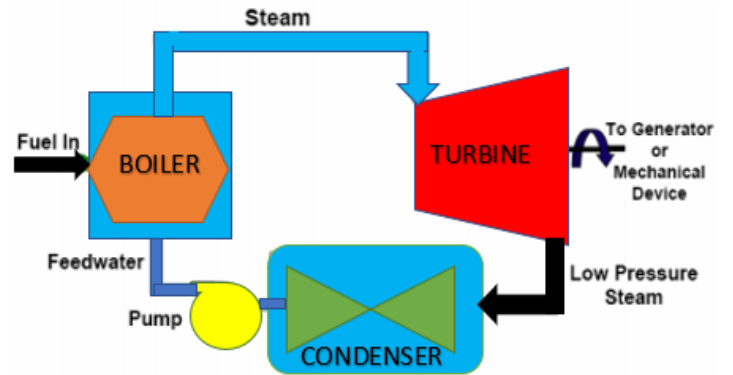
Figure 2. Schematic of injection steam turbine.